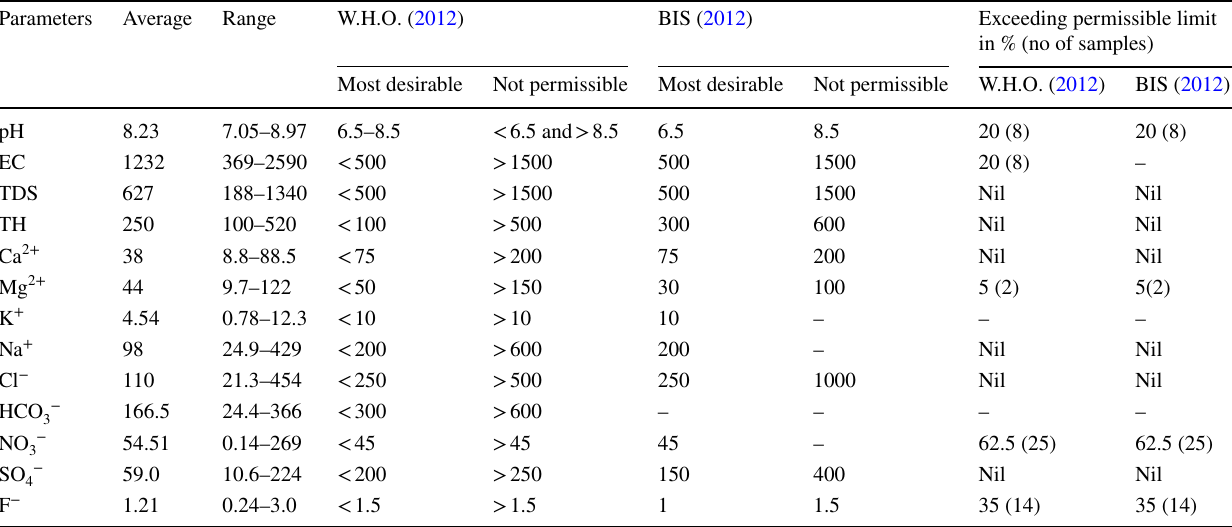
Table 4 Statistical data of physicochemical parameters of groundwater